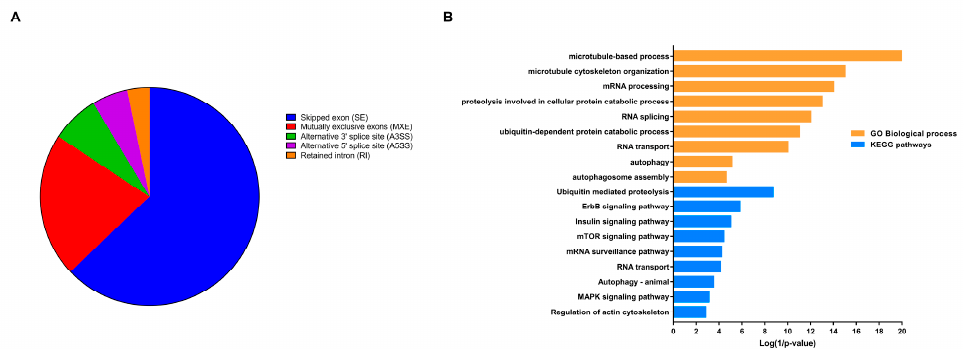
Figure 4. Overview of alternative splicing (AS) in embryonal tumor with multilayered rosettes (ETMR) and enrichment analysis of genes with AS events. ( A ). Pie chart showing genes’ count with di ff erent AS events. ( B ). Biological processes and KEGG pathways enriched by significant alternatively spliced genes.